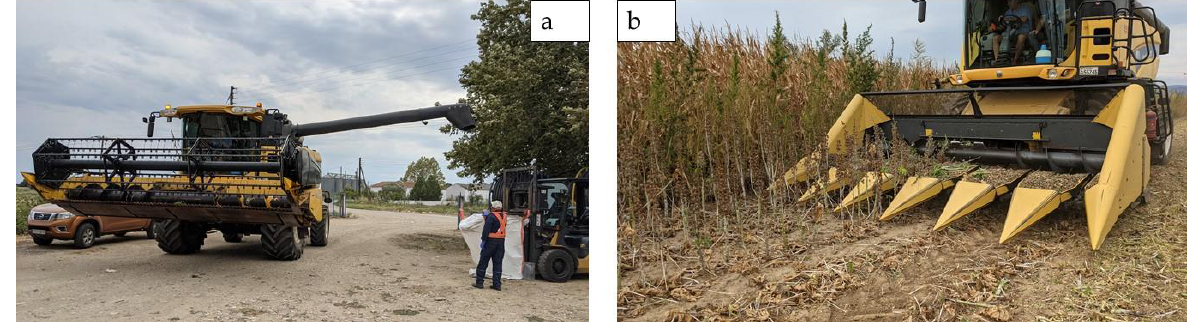
Figure 2. ( a ) New Holland CX8060 combine harvester with cereal header. ( b ) New Holland CX8060 combine harvester with sunflower header.